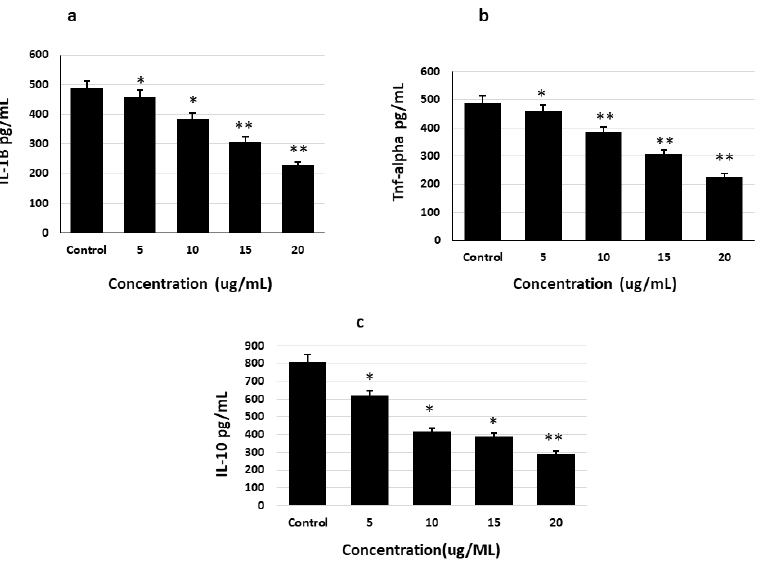
Figure 6. Inhibitory effects of theasaponin E1 on the inflammation-promoting cytokines IL-1B, IL-6, and TNF alpha in glial cells determined by specific ELISA kits. ( a ). Inhibitory effects of theasaponin E1 on IL-1B. ( b ). Inhibitory effects of theasaponin E1 on TNF alpha. ( c ). Inhibitory effects of theasaponin E1 on IL-6. Data shown here are the mean values ± SEM. Data were analyzed using one-way ANOVA ( n = 3) and were statistically considered significant at p < 0.05 (* p < 0.05; ** p < 0.01 to the control group).